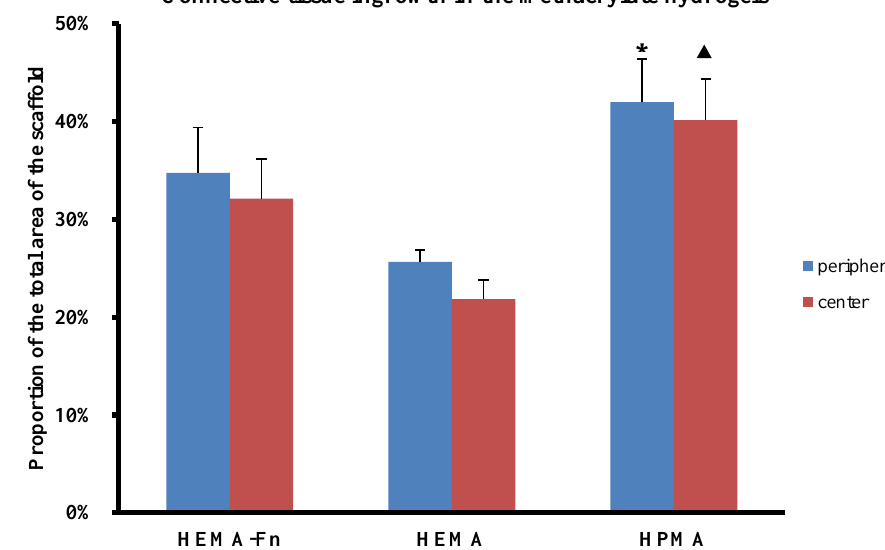
Figure 5. Comparison of connective tissue ingrowth within the three hydrogels. The graph presents the percentage of HE-positively stained tissue within the whole area of the peripheral (blue bars) and central (red bars) regions of the hydrogel. The HPMA scaffold showed higher connective tissue ingrowth within the periphery (* p < 0.05) as well as the central part ( ▲ p < 0.05) of the HEMA scaffold. Data shown as mean, and the error bars represent SEM. For statistical analysis, a one-way ANOVA test was used.